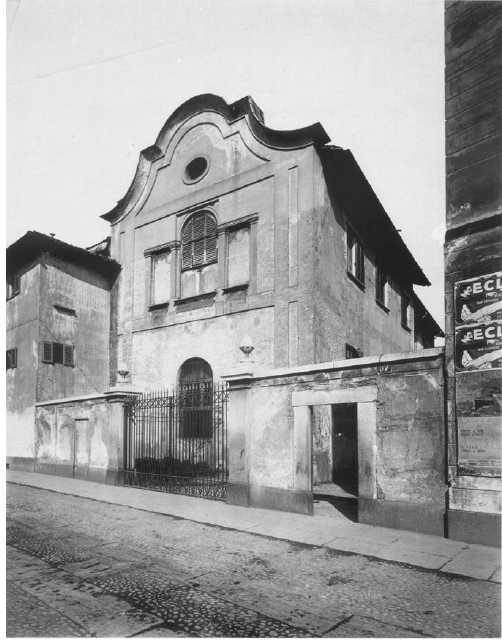
Figure 13. Milano